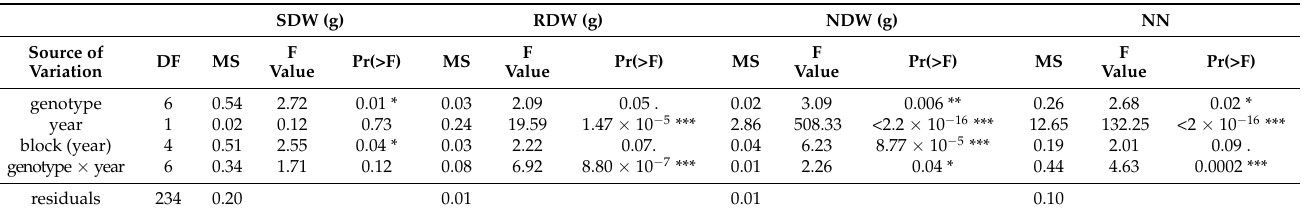
Table 1. Analyses of variance for the plant growth and nodulation of seven chickpea genotypes grown under a low-P